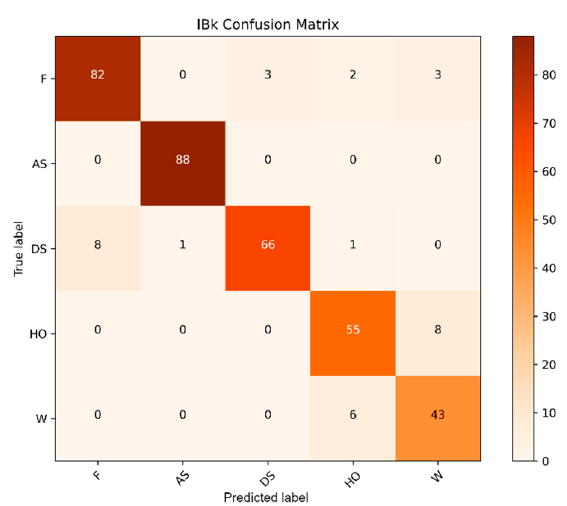
Figure 16. Confusion matrix (IBk classifer).